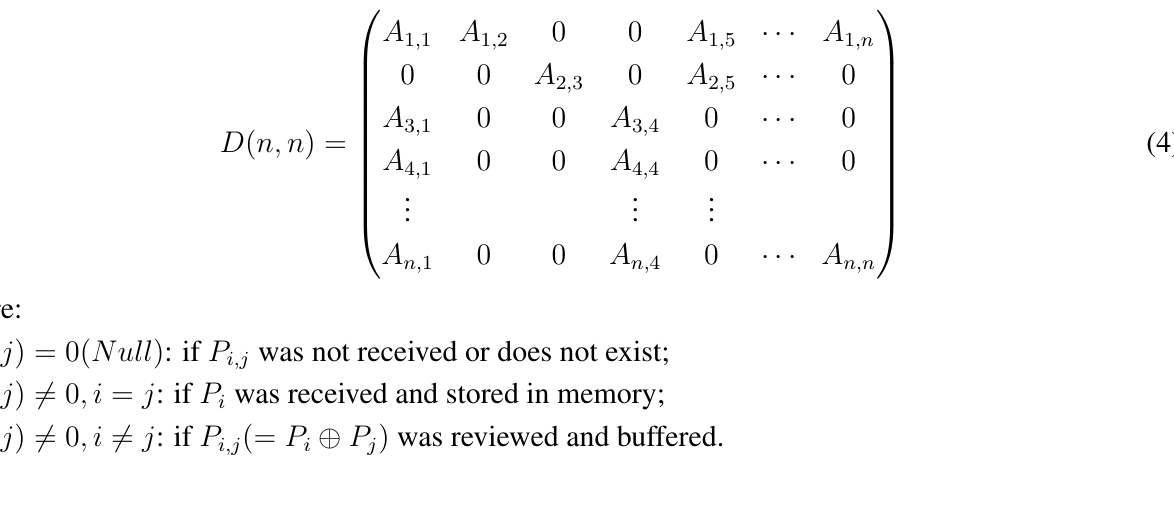
Algorithm 2 : Recovery process at Personal Server /monitoring station